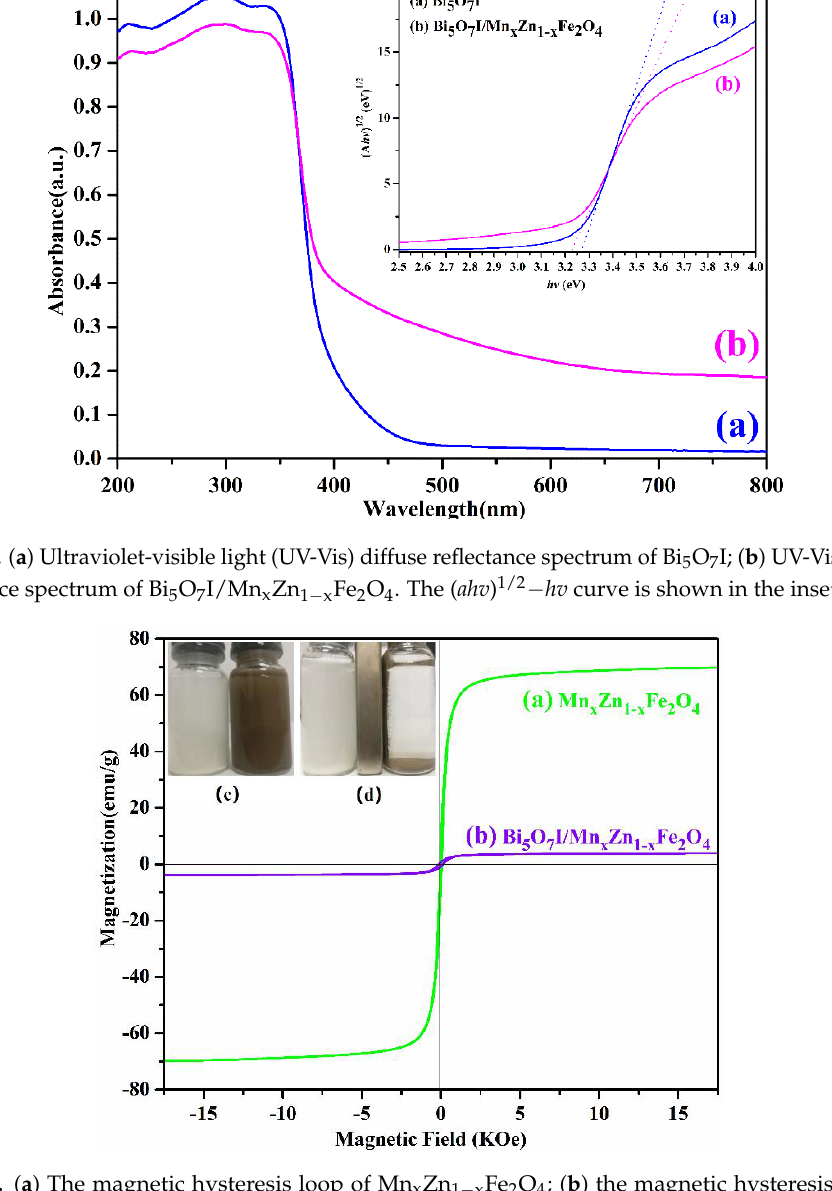
Figure 8. ( a ) The magnetic hysteresis loop of Mn x Zn 1 − x Fe 2 O 4 ; ( b ) the magnetic hysteresis loop of Bi 5 O 7 I/Mn x Zn 1 − x Fe 2 O 4 . In the inset images, ( c ) the suspension of Bi 5 O 7 I and Bi 5 O 7 I/Mn x Zn 1 − x Fe 2 O 4 , and ( d ) the suspension of Bi 5 O 7 I and Bi 5 O 7 I/Mn x Zn 1 − x Fe 2 O 4 are shown under the magnetic field.